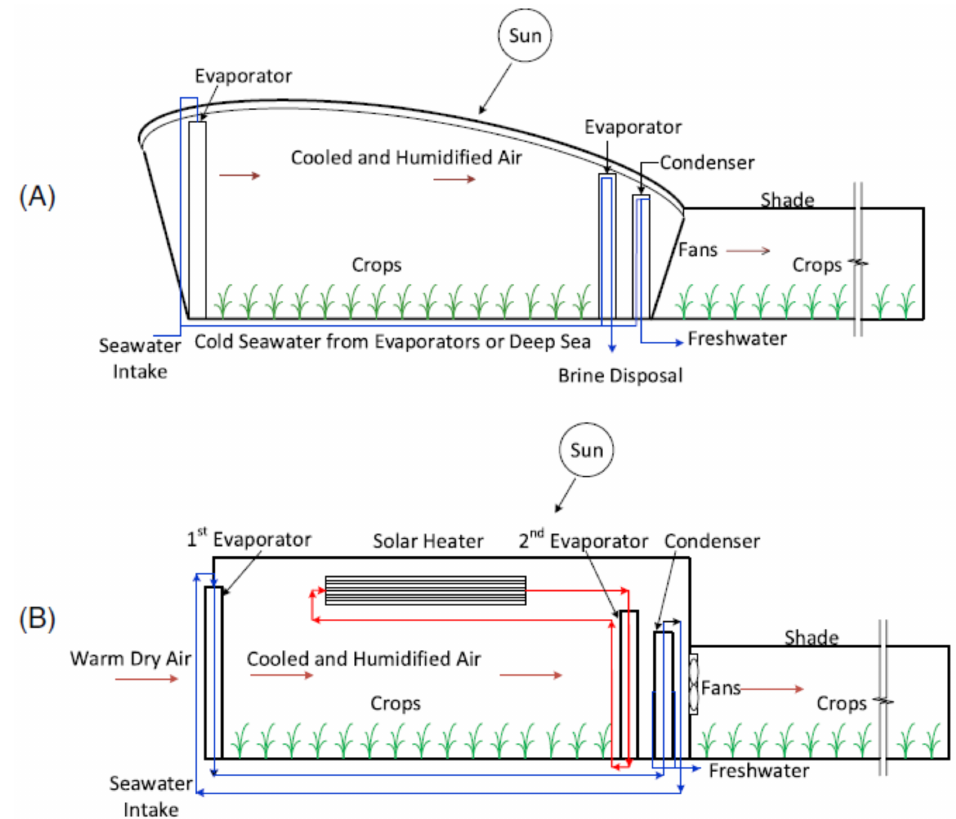
Figure 3. ( A ) The concept of solar HD -based greenhouse and ( B ) solar HD-based greenhouse in Oman